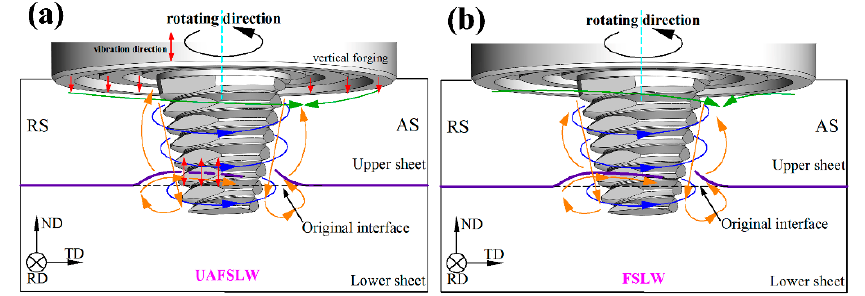
Figure 8. Schematic showing material flow behaviour during UAFSLW and FSLW. ( a ) UAFSLW; ( b ) FSLW.